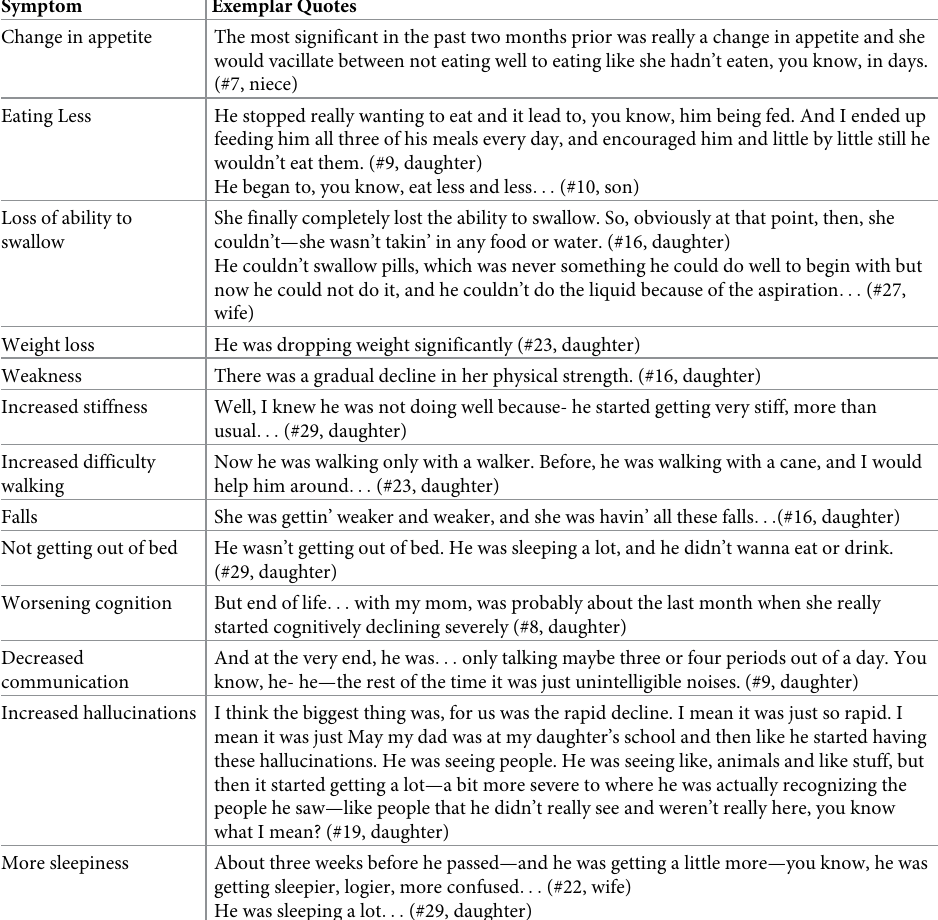
Table 1. Reported symptoms in the end-of-life